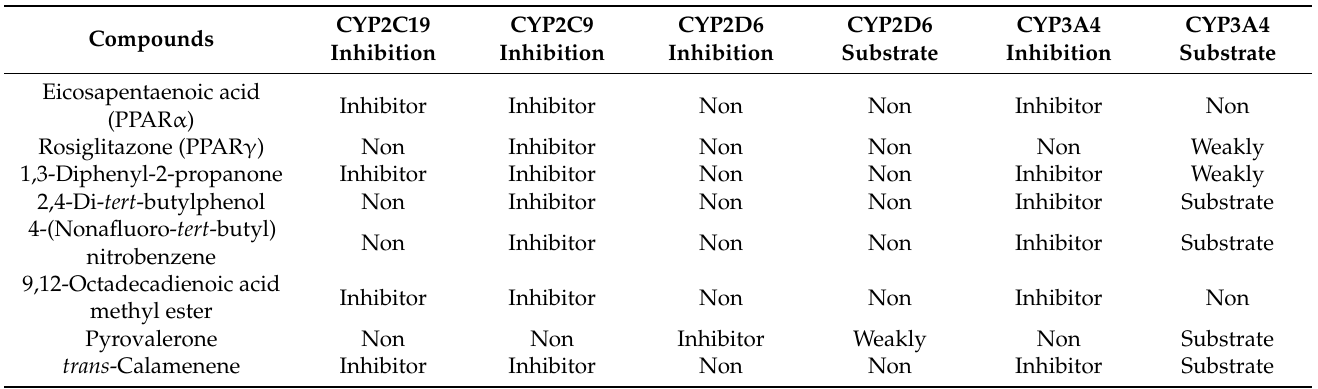
Table 11. In silico metabolism profile of CGJ, a volatile compound obtained from the PreADMET server. Compounds